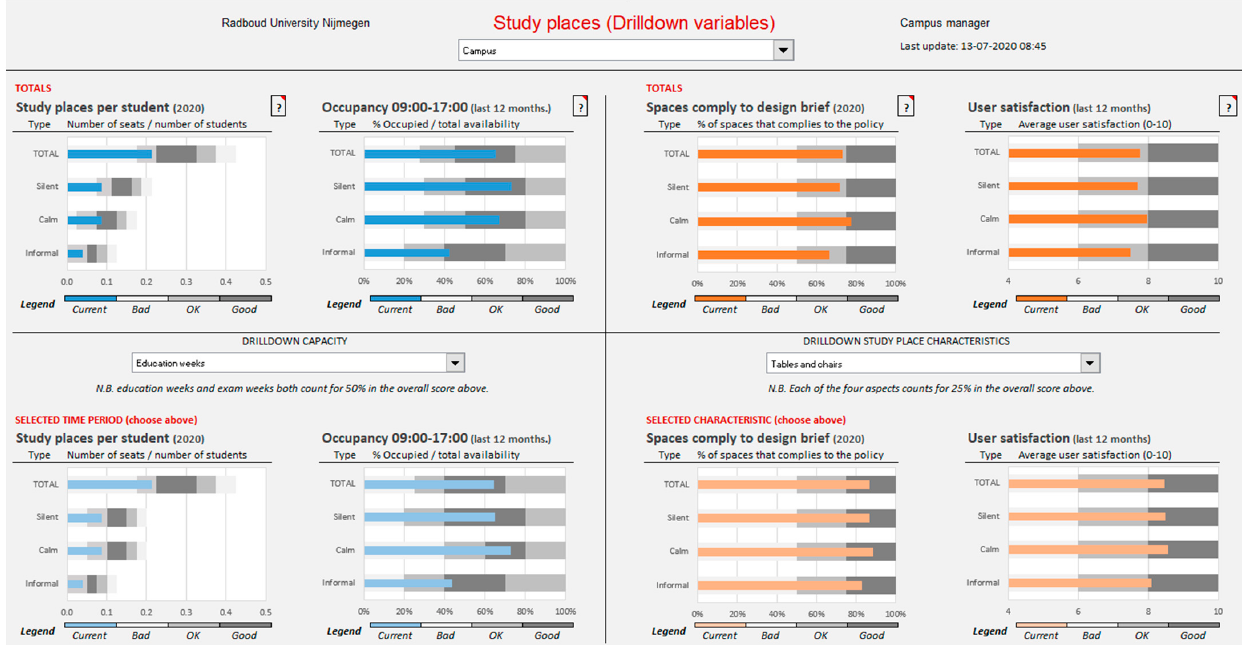
Figure A1. Buildings dashboard ‘Study places Radboud University’ (tested in workshop 2).